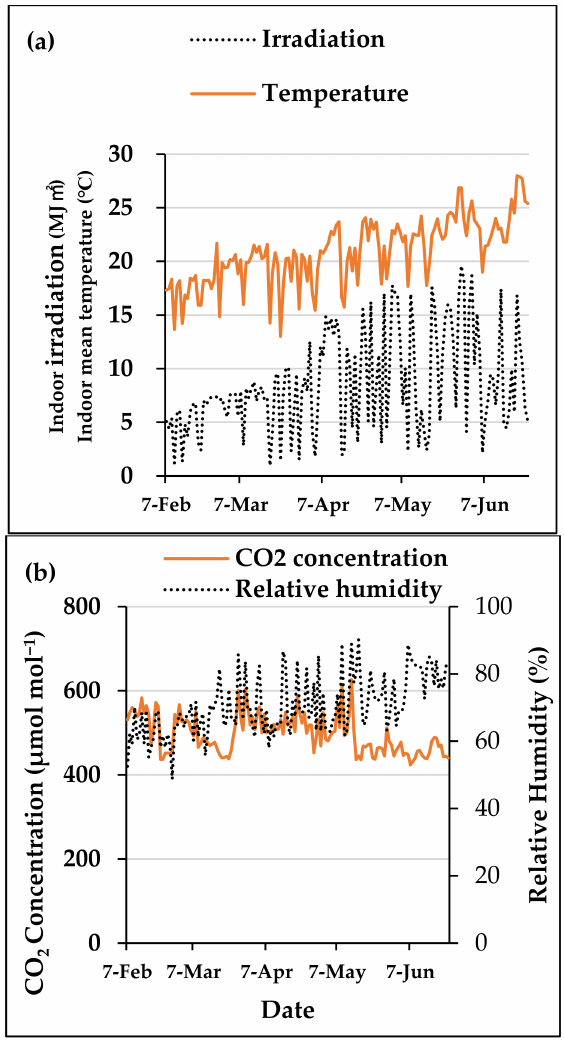
Figure 5. Daily mean temperature and irradiation ( a ), and daily average relative humidity and CO 2 concentration ( b ) in the greenhouse.